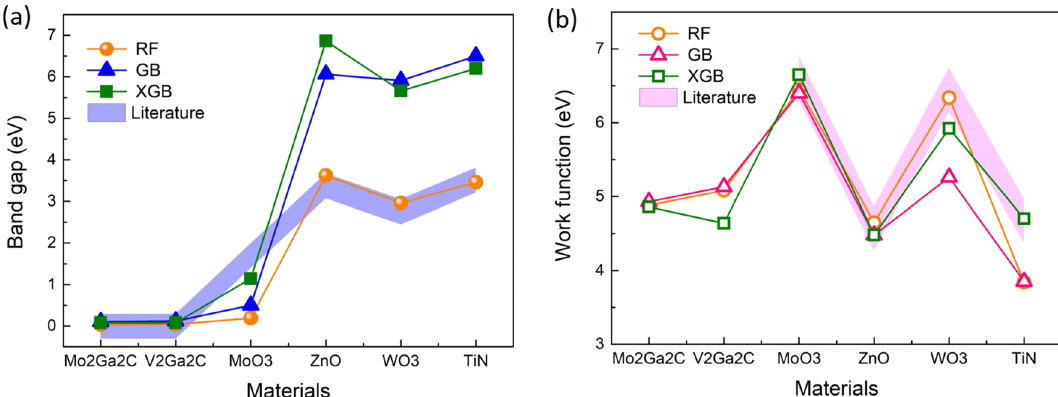
Figure 7. Prediction outcomes of the trained models (RF, GB, XGB) with help of descriptor engineering on selected 2D materials that are not available in the C2DB dataset. The filled areas [violet for band gap ( a ) and magenta for work function ( b )] represent values collected in the literature within the error range of 0.3